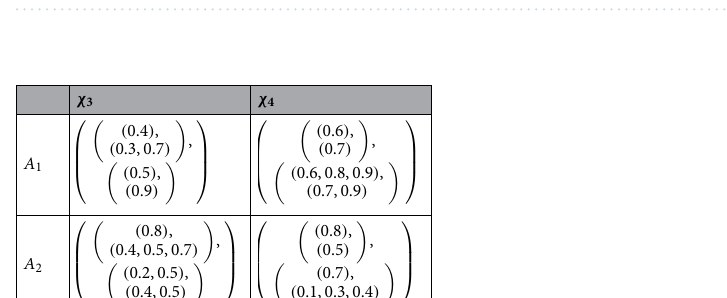
Table 2. Decision making information.